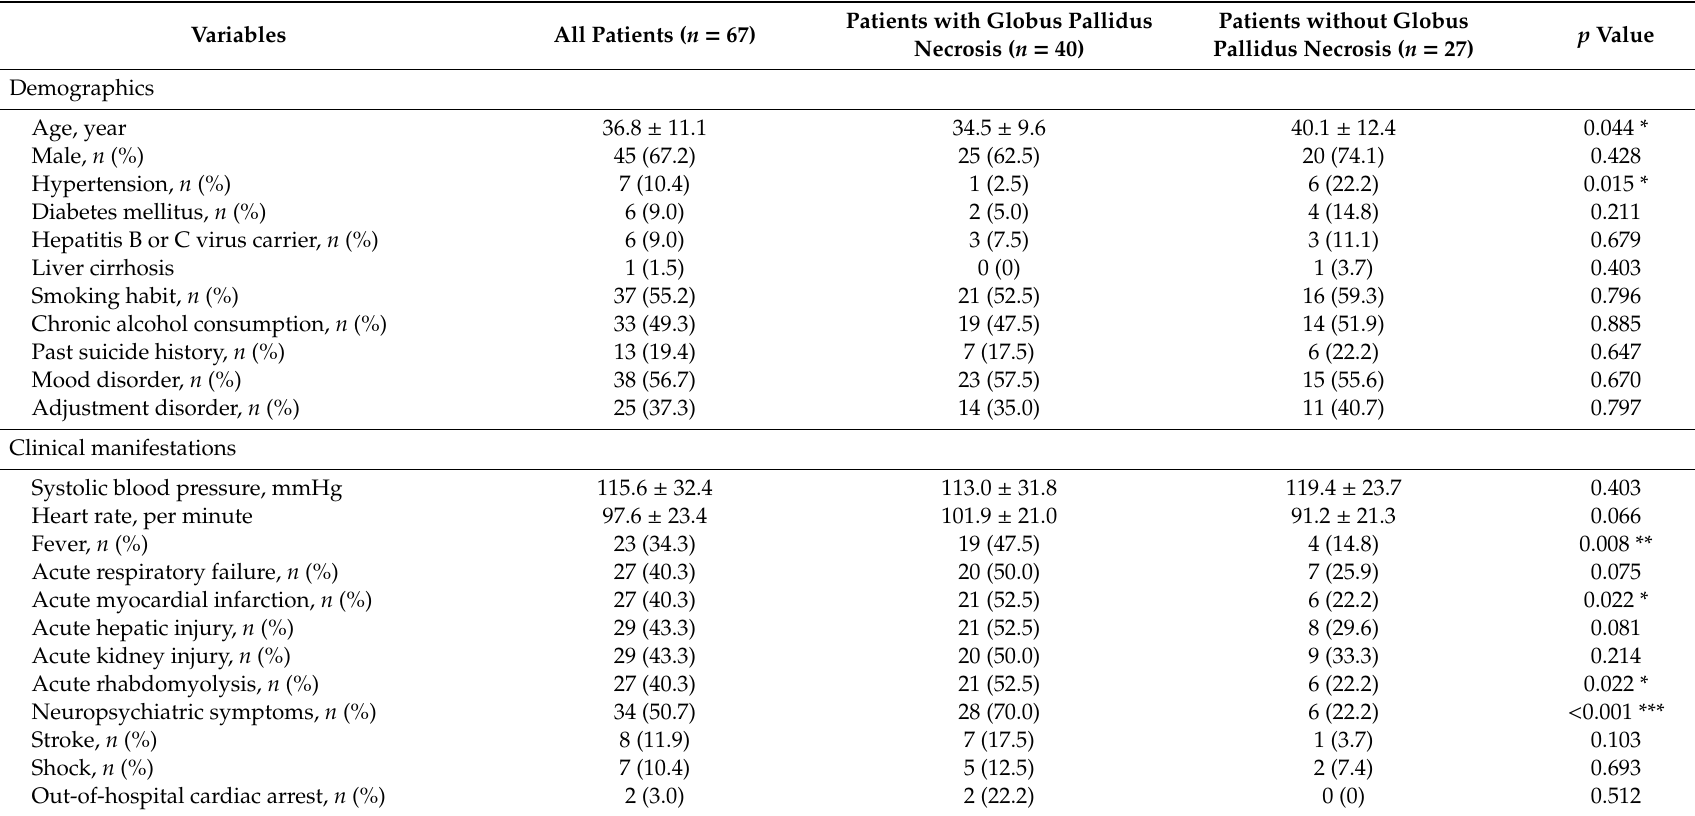
Table 1. Clinical data of patients who had attempted charcoal burning suicide, stratified by either presence or absence of globus pallidus necrosis ( n = 67).